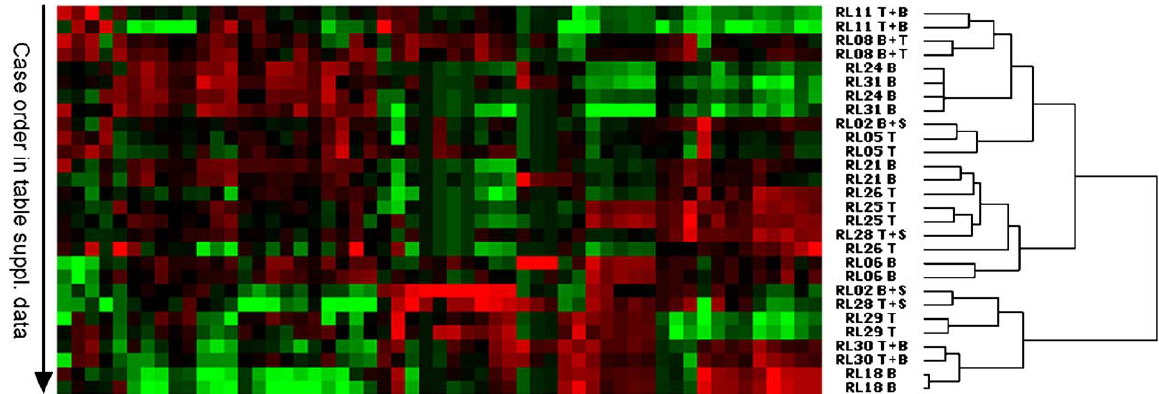
Fig. 6. Unsupervised classification of the reactive lymph node cases that contain different combinations and amounts of B-cells, T-cells and sinus histiocytosis. Along the Y-axis are the benign lymph node cases (each case in duplicate) (RL = benign lymph node). Behind the sample name is indicated which hyperplasia type and thus which cell type is predominantly present in the sample (B: B-cells or follicular hyperplasia, T: T-cells or paracortical hyperplasia, and S: sinus histiocytosis). Detailed information on hyperplasia composition is provided in Table 2.